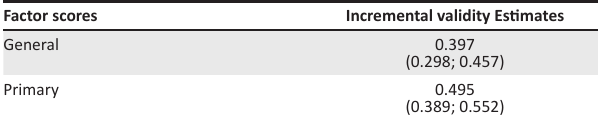
TABLE 7: Stage-3 results: External validity assessment (Part b). Factor scores Incremental validity